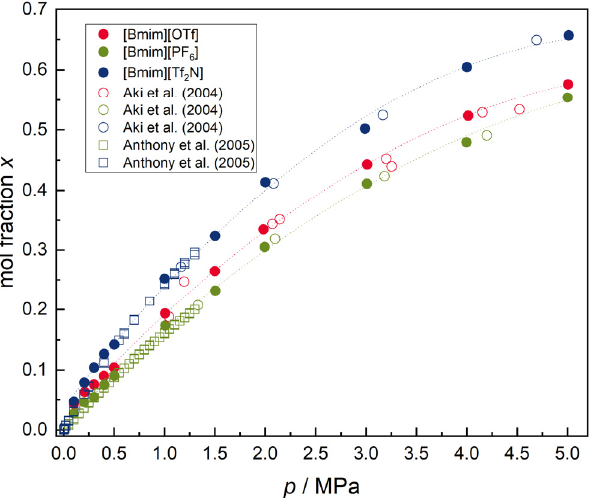
Figure 5. Solubility of carbon dioxide in [Bmim][OTf], [Bmim][PF 6 ] and [Bmim][Tf 2 N] at T = (298.21, 298.17, 298.22) K, respectively. Literature date are reported in references [14,15]. Uncertainty values are not shown for clarity but are provided in Appendix B.